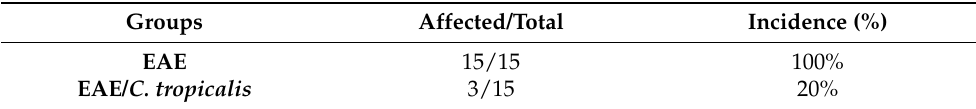
Table 2. EAE incidence. Female C57BL/6 mice were infected with 1 × 10 6 viable C. tropicalis yeasts three days before EAE induction and evaluated for the incidence of EAE until the 16th day after EAE